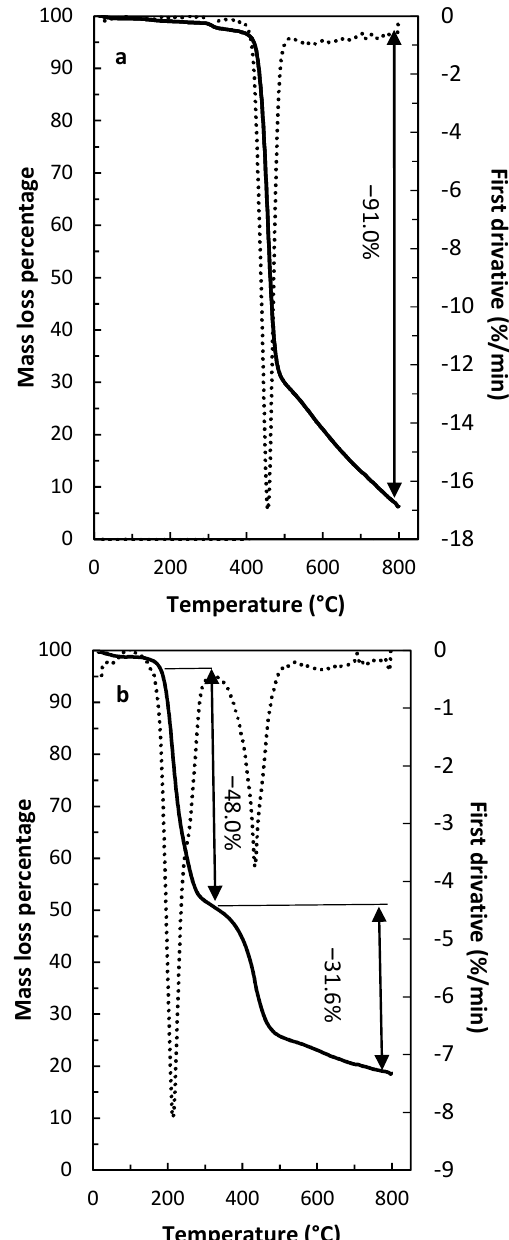
Figure 13. TGA and DTGA thermograms of ( a ) the PVDF-HFP film and ( b ) the optimized PIM (50 wt% PVDF-HFP, 40 wt% Aliquat ® 336 and 10 wt% DBP) obtained under N 2 atmosphere. The stress–strain curves of the blank PVDF-HFP film and the optimized PIM (50 wt% PVDF-HFP, 40 wt% Aliquat ® 336 and 10 wt% DBP) (Figure 14) showed that the presence of the membrane liquid phase in the optimized PIM led to a drastic reduction in tensile stress, i.e., from 33.2 to 5.2 MPa, in the peak point. More importantly, the addition of extractant and plasticizer/modifier resulted in significant increase in flexibility, reaching a maximum at around 500% of elongation.